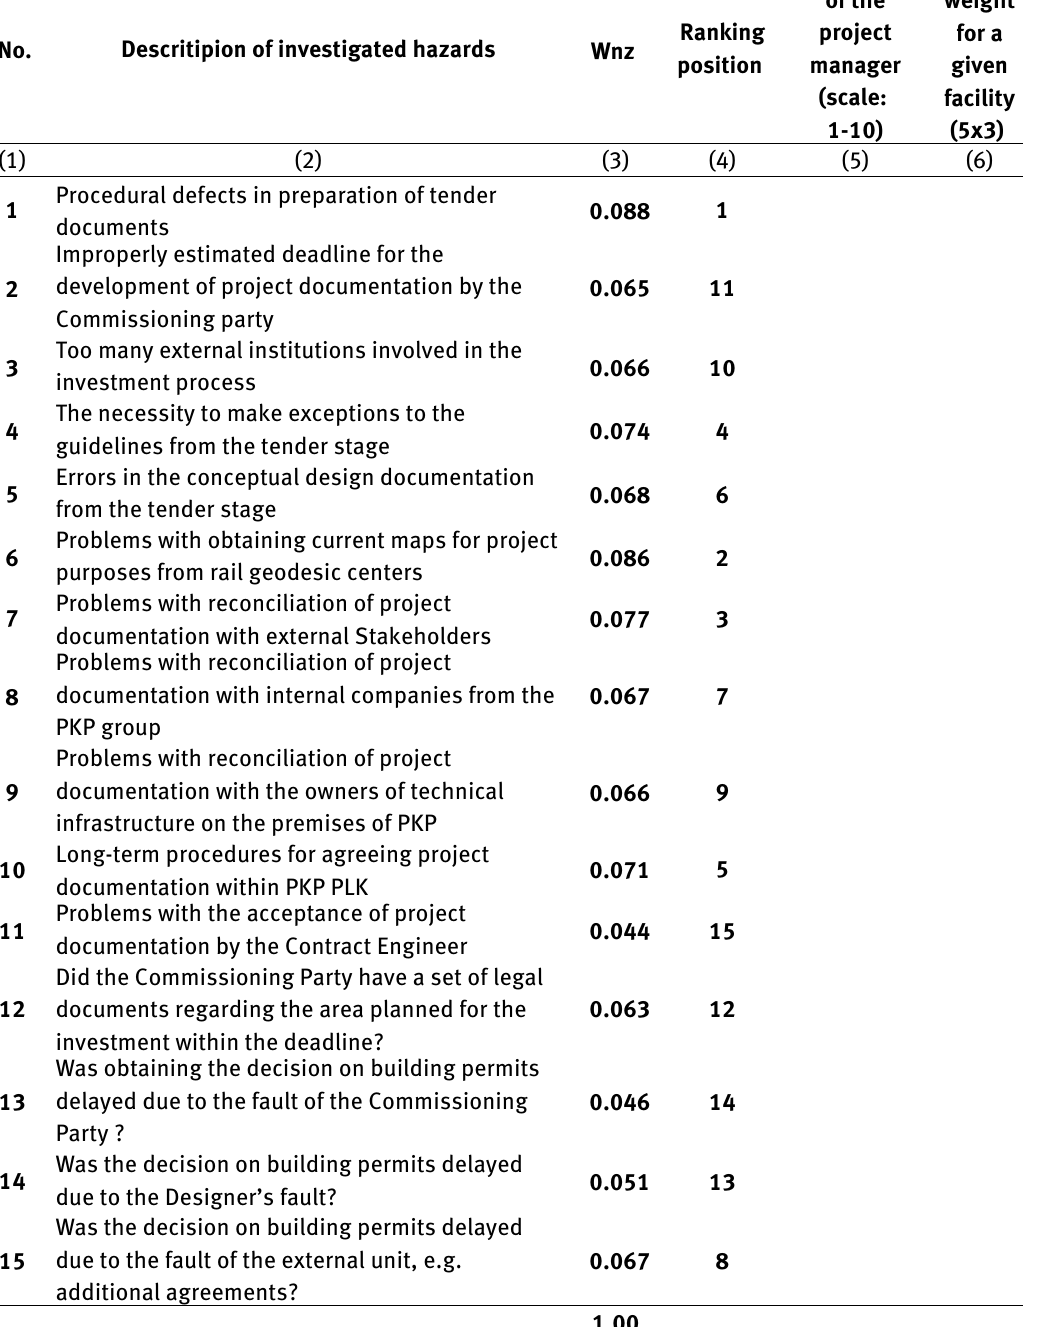
Table 3: Risk matrix with values of normalized weights and their ranking position for KT = KK =0.5 – design stage.